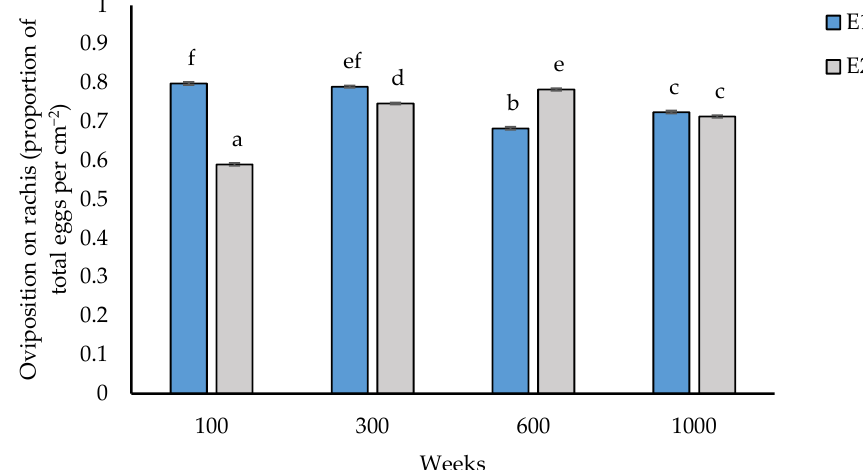
Figure 5. Ommatissus lybicus oviposition on rachis (proportion of total eggs per cm − 2 palm area) in experiments. Predicted means with standard error bars were derived by generalized linear model with binomial distribution with link function of logit ( p < 0.001). Fisher’s least significant difference test was used for comparisons. Different letters indicate statistically significant differences ( p < 0.05) between means. Experiment = E.